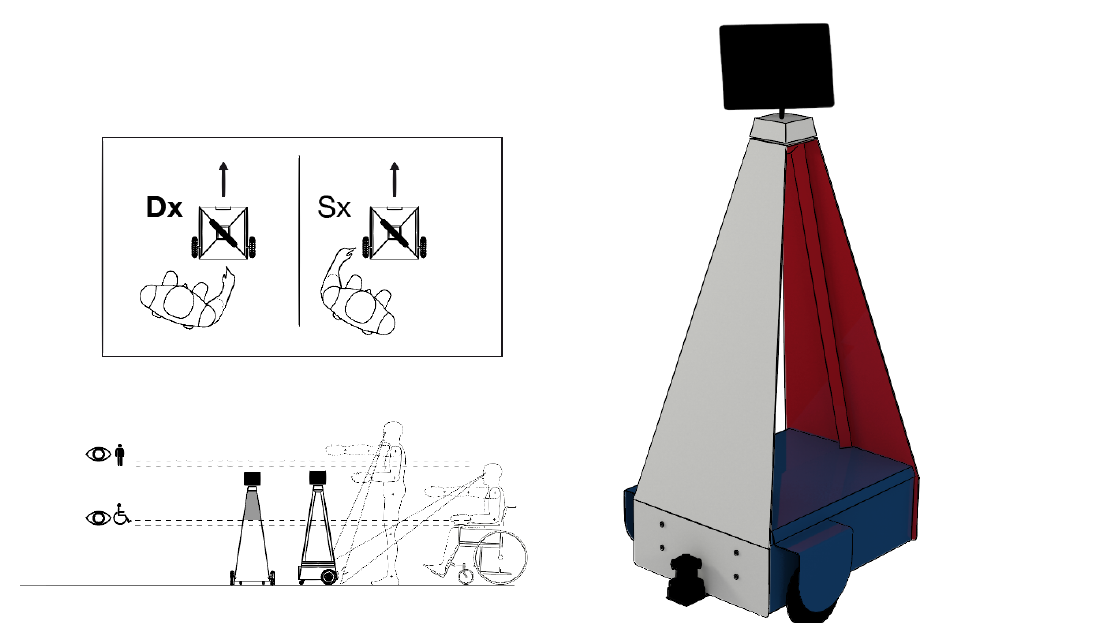
Figure 4. The general appearance of the robot is designed to be integrated into the building’s lobby, and resemble part of the architecture. The colours chosen are the official ones used from the company’s brand. The robot has been designed to support ergonomic aspects that take into account accessibility and